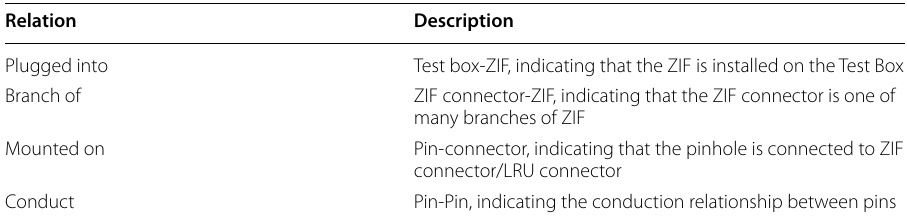
Table 2 Relations between AWTE entities